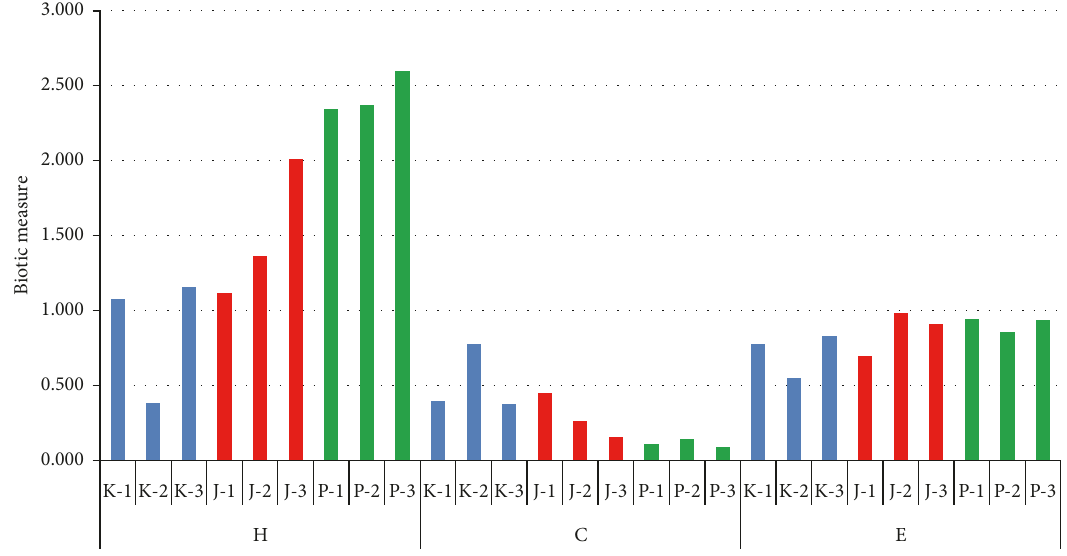
Figure 2: Diversity Index (H), Dominance Index (C), and Evenness Index (E) in December 2015.